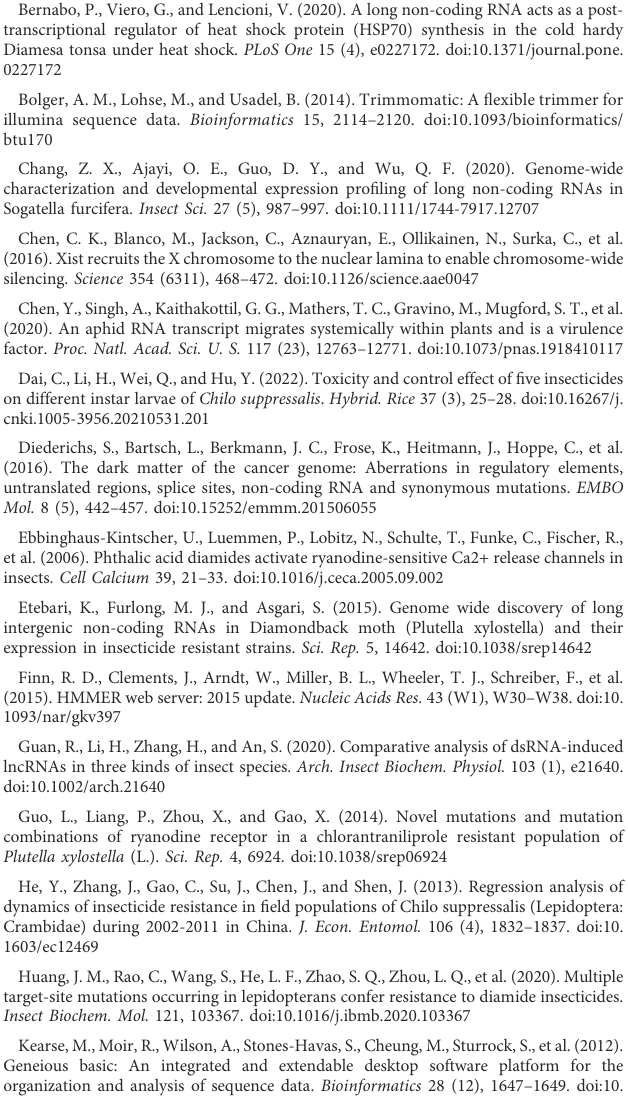
SUPPLEMENTARY FIGURE S1 Expression pro fi le of MSTRG.7482.1 in different stages across life time in the S strain. Each column represents the mean of three biological samples. Error bars represent the standard deviation from the mean. The change in the expression level was calculated using the 2 - ΔΔ Ct method. Data were normalized to the expression of housekeeping genes (Actin A1). Different letters on the error bars show signi fi cant differences ( p <